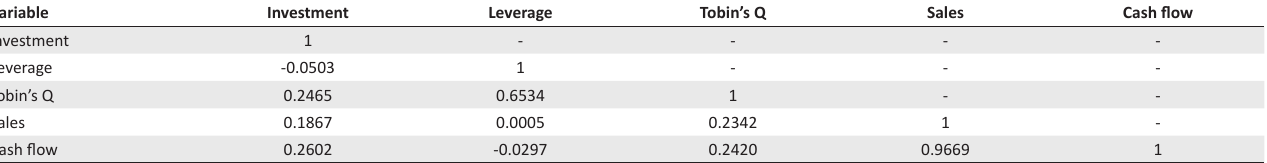
TABLE 3: Correlation matrix of the variables used in the regression when total liabilities are the dependent variable . Variable